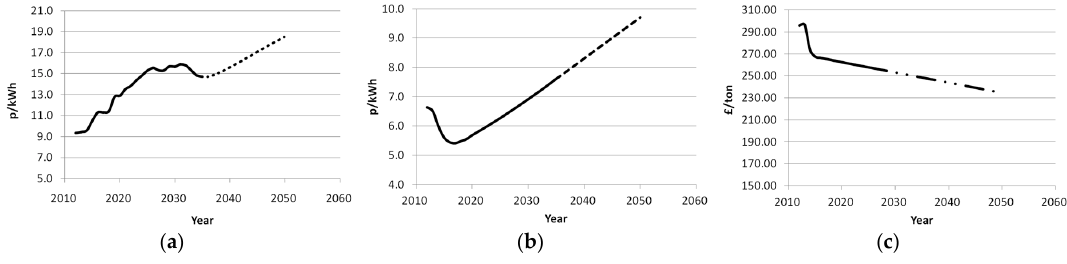
Figure 4. ( a ) Projected electricity prices; ( b ) projected fuel prices (kerosene/gas-oil); and ( c ) projected fertiliser prices (average of nitrogen, potash and phosphate based